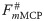
Correlation between the finger joint angle and the traction force of digital flexor muscles in digit III during a cylindrical grip and suspensory hand posture.The differences in FmMCP, FmPIP during a cylindrical grip (A), FmMCP#, and FmPIP# during a suspensory hand posture (B) were compared among Hylobates spp., Papio hamadryas, and Ateles sp. using generalized estimating equations (GEE). Circles, triangles, and squares show the data of Hylobates spp., Papio hamadryas, and Ateles sp, respectively. Symbols filled with black, R2 of the regression ≥0.7; symbol filled with gray, R2 of the regression ≥0.4; open symbol, R2 of the regression <0.4. Regression equations are shown in S7 and S8 Tables.